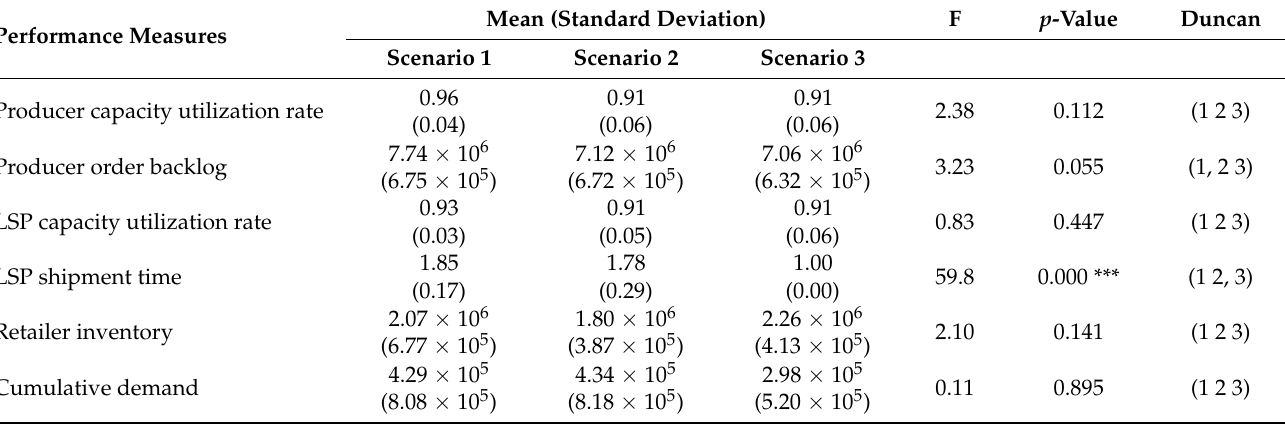
Table 6. The MANOVA results for a demand